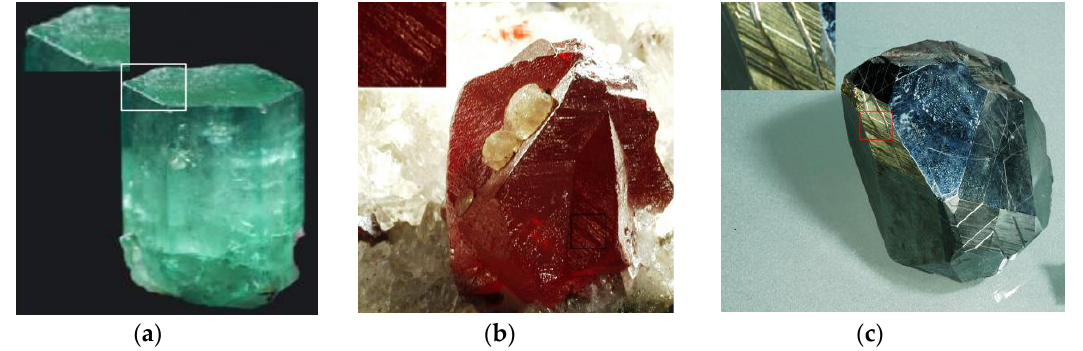
Figure 3. Samples of rock mineral characteristics [42]. ( a ) Aquamarine; ( b ) cinnabar; ( c ) hematite.